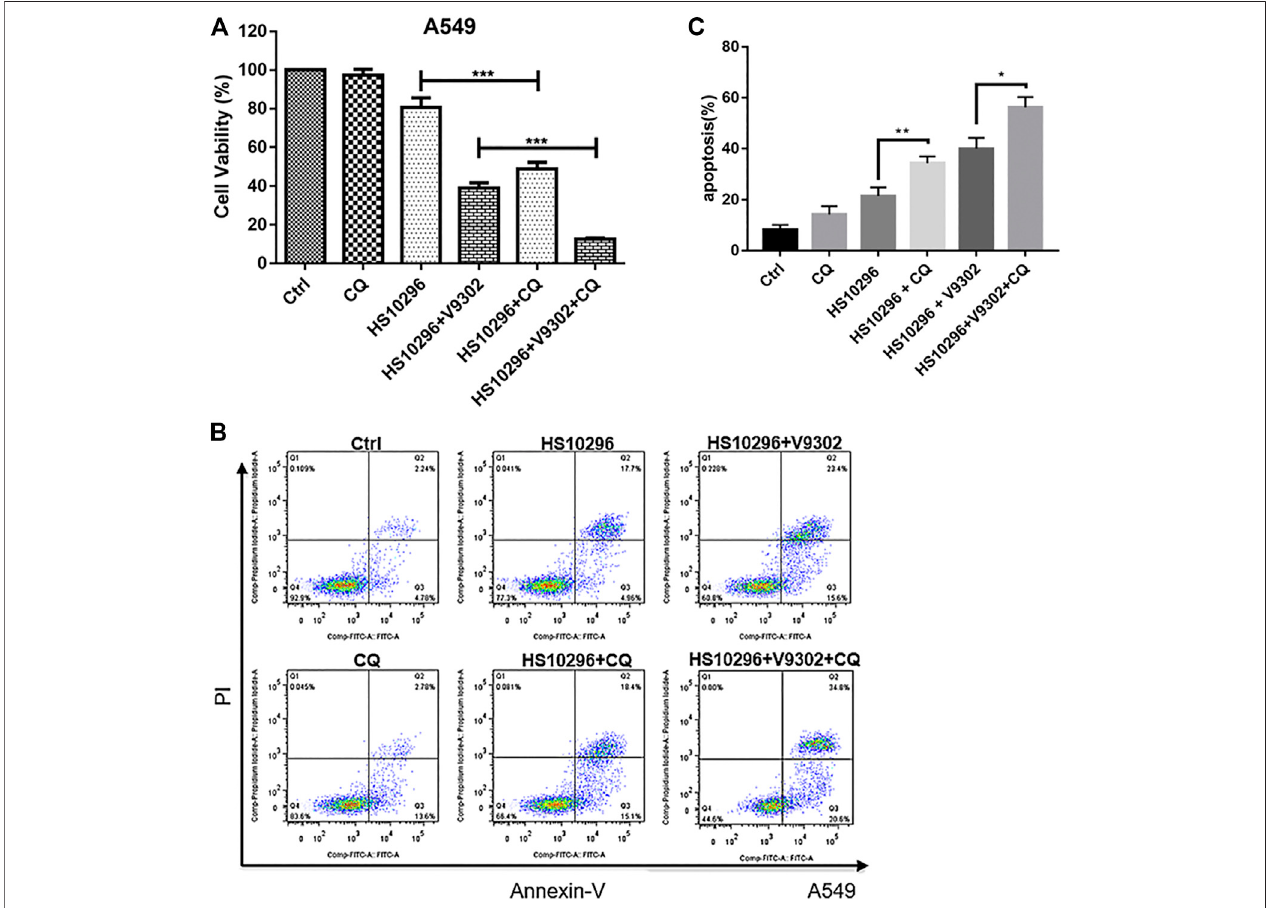
FIGURE 7 | CQ increased the proliferation inhibitory effect of Almonertinib combined with V9302 on A549 cells and induces apoptosis. (A) CCK8 assay was used todeterminetheeffectofCQontheproliferationinhibitionofAlmonertinibandV9302co-treatedA549cells. (B,C) Doublestainingassaywasusedtodetecttheeffectof CQ on the induction of apoptosis of A549 cells treated with Almonertinib and V9302. Signi fi cance: * p < 0.05, ** p < 0.01,*** p < 0.001.